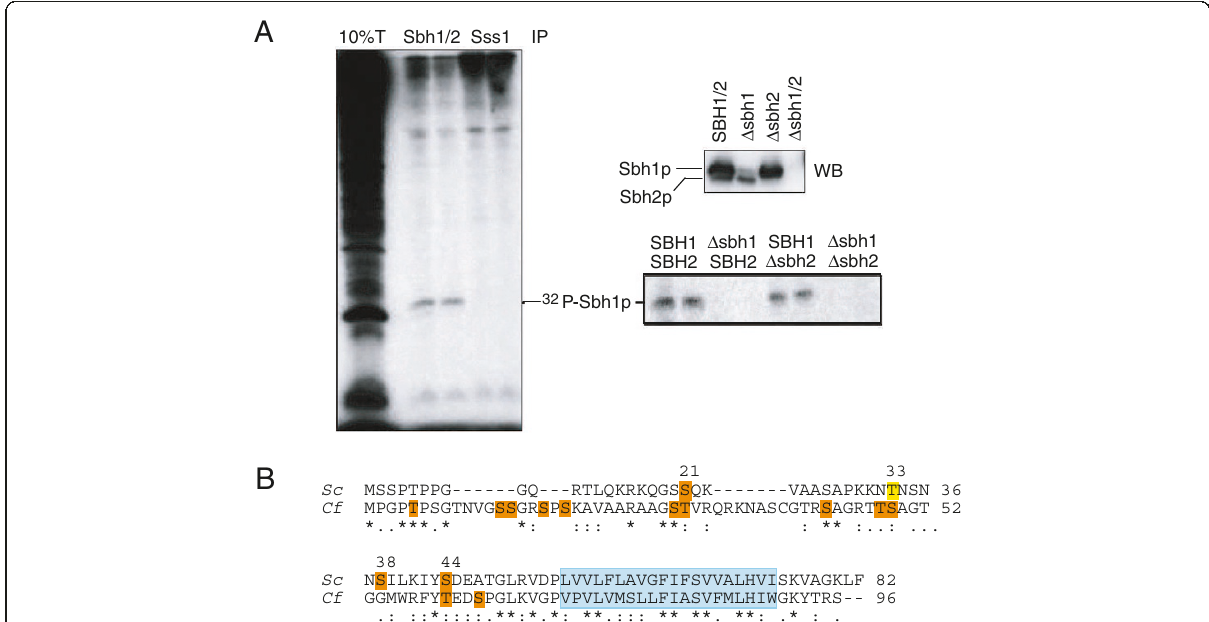
Figure 1 Sbh1p can be phosphorylated in yeast ER membranes. ( A ) Left: Wildtype microsomes (5eq) were incubated with g-[ 32 P]ATP (40 μ Ci) for 30 min. Membranes were lysed in SDS, and Sbh1p and Sss1p immunoprecipitated with polyclonal rabbit antisera in duplicate. Precipitated proteins and 10% of the lysate were resolved on a 15% SDS gel and detected by autoradiography. Upper right: Microsomes (1 eq) of the indicated strains were lysed, proteins resolved on a 15% SDS gel, and Sbh proteins detected with an antiserum directed against the first 18 amino acids of Sbh1p. Lower right: Microsomes from the indicated strains were labelled with γ -[ 32 P]ATP as above and Sbh proteins precipitated in duplicate. Proteins were resolved on a 15% gel and detected by autoradiography. ( B ) Alignment of S. cerevisiae Sbh1p and Canis familiaris Sec61ß. Transmembrane domains are indicated in blue. Phosphorylation sites predicted by NetPhos are shown in orange, an additional site predicted by Scan Prosite in